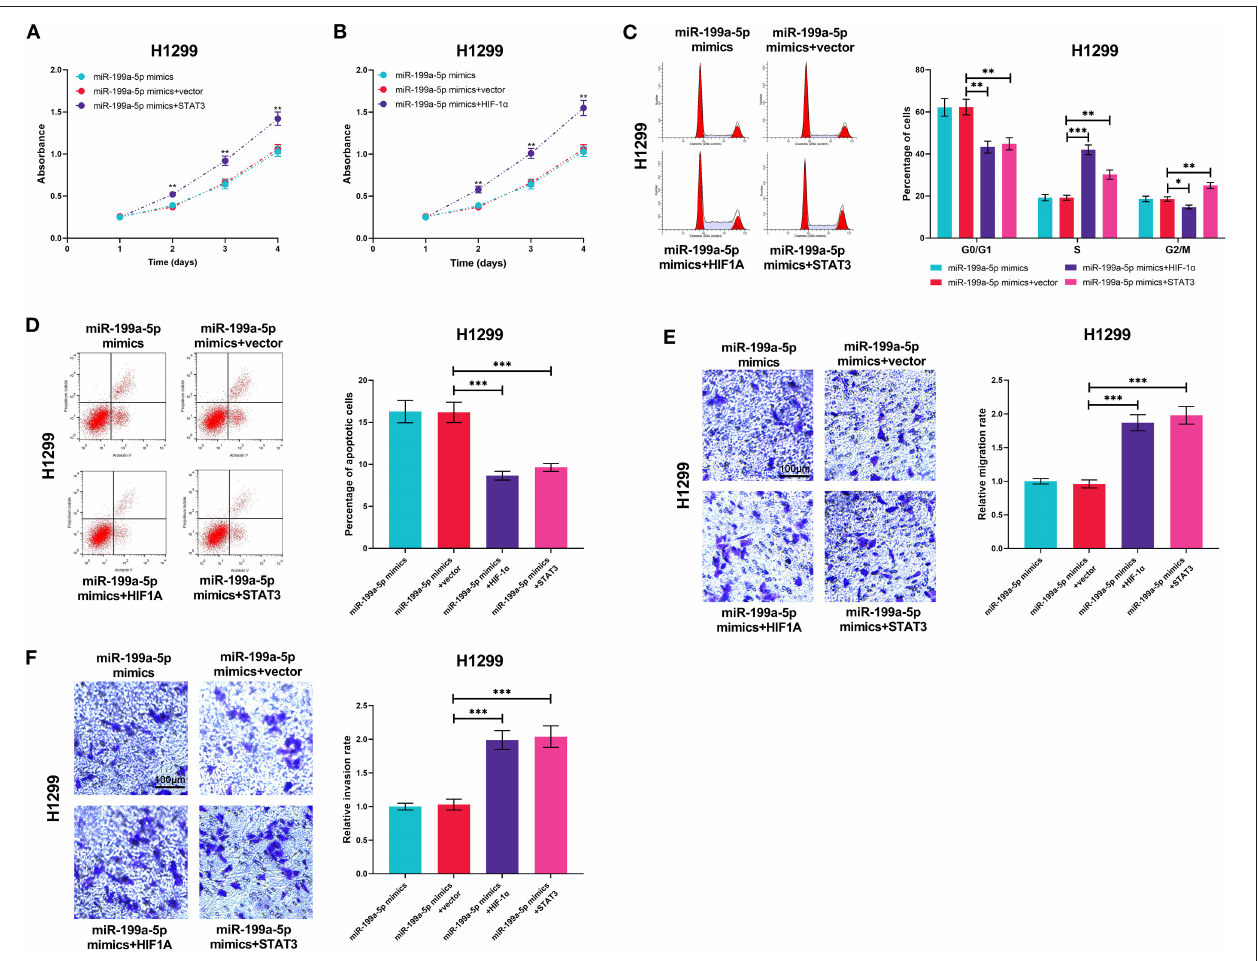
FIGURE 7 | HIF-1 α overexpression or STAT3 overexpression reversed the biological effects of miR-199a-5p on H1299 cells. H1299 cells were transfected with miR-199a-5p mimics or co-transfected with miR-199a-5p mimics and STAT3 overexpression plasmids (or HIF-1 α overexpression plasmids). (A,B) CCK-8 assay was performed to measure the proliferation of H1299 cells. (C,D) Flow cytometry was used to detect H1299 cell cycle and apoptosis. (E,F) Migration and invasion of H1299 cells were analyzed employing the Transwell assay. All of the experiments were performed in triplicate. * p < 0.05, ** p < 0.01, and *** p < 0.001,